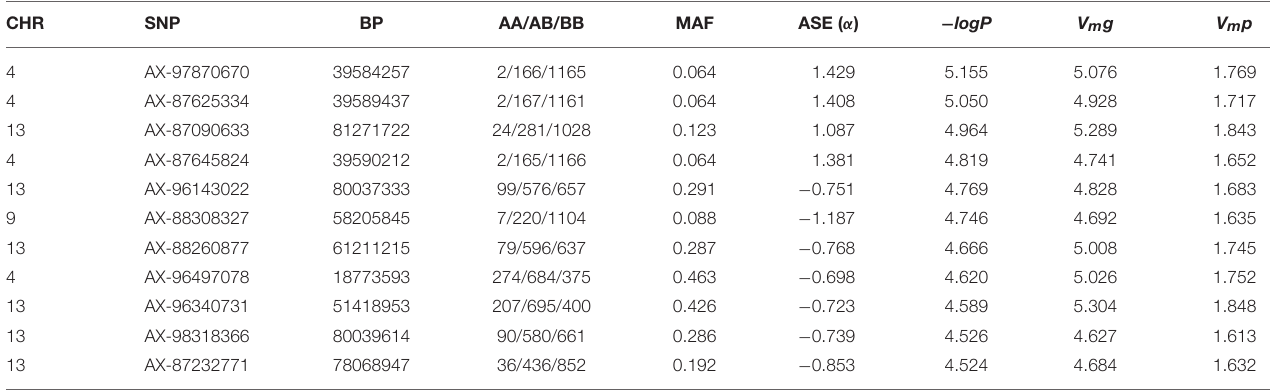
TABLE 2 | Summary statistics of QTL regions associated with AGD infection.